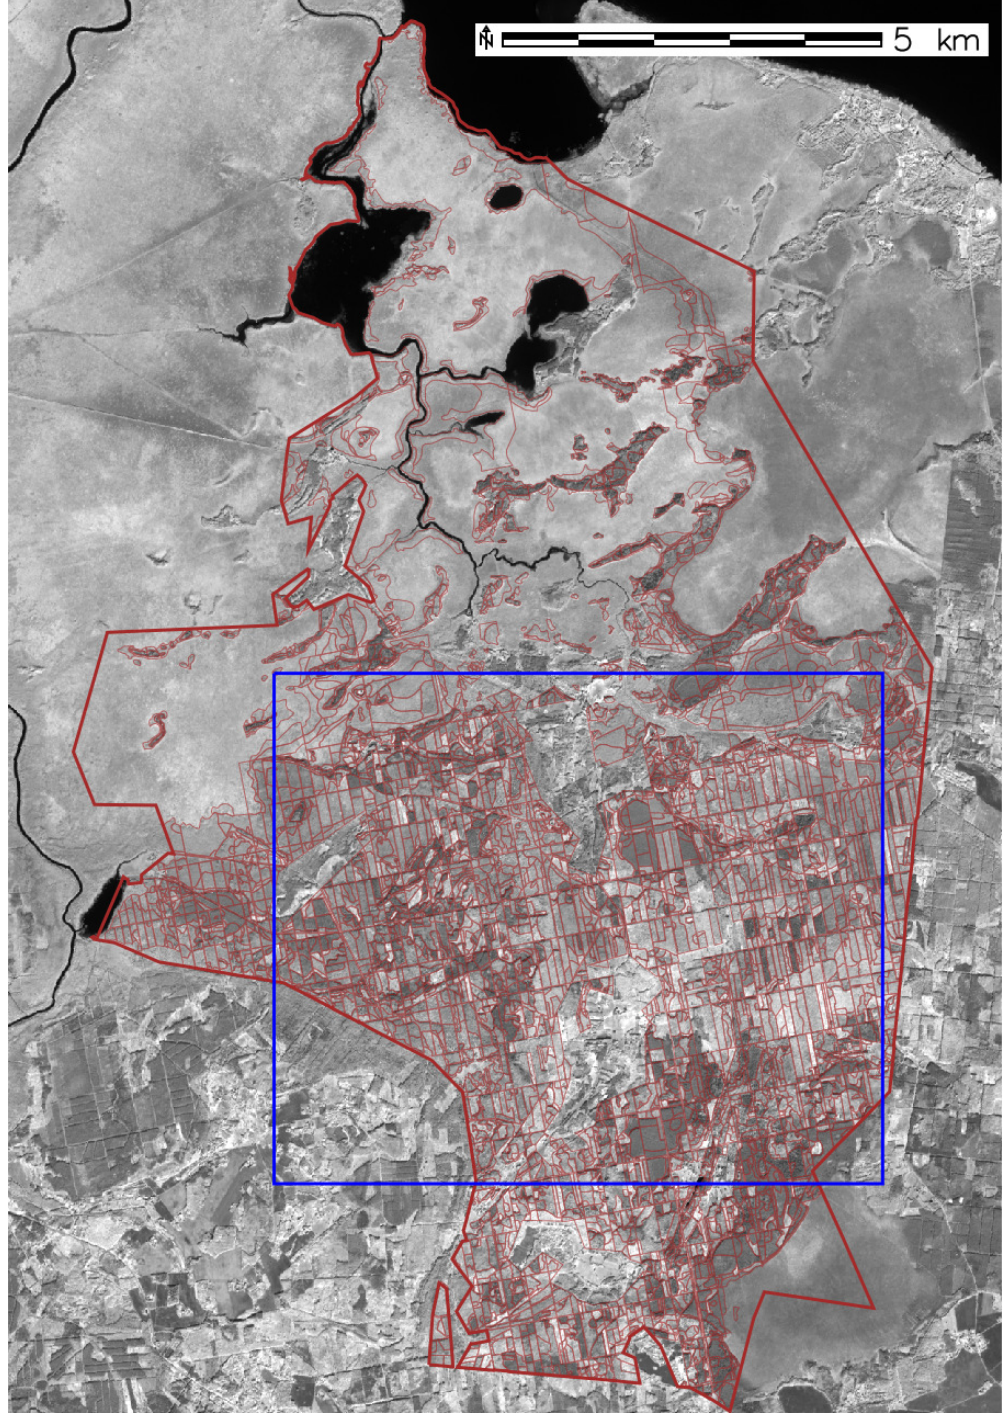
Figure 9. Sentinel-2 MSI image B7 (780 nm) of the test site on 18 August 2019. Brown lines mark the contours of the forest district and of the individual stands. The blue rectangle marks the region of Figure